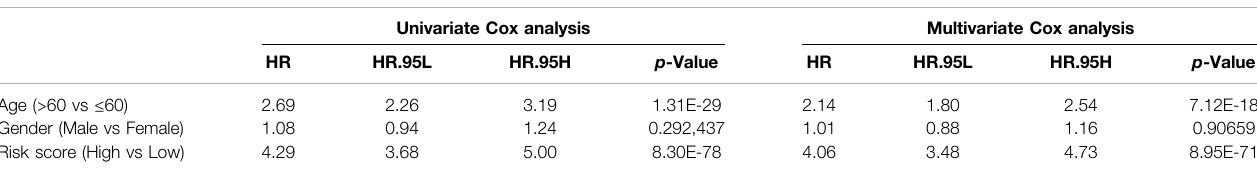
TABLE 4 | OS prediction for m6A groups with univariate and multivariate